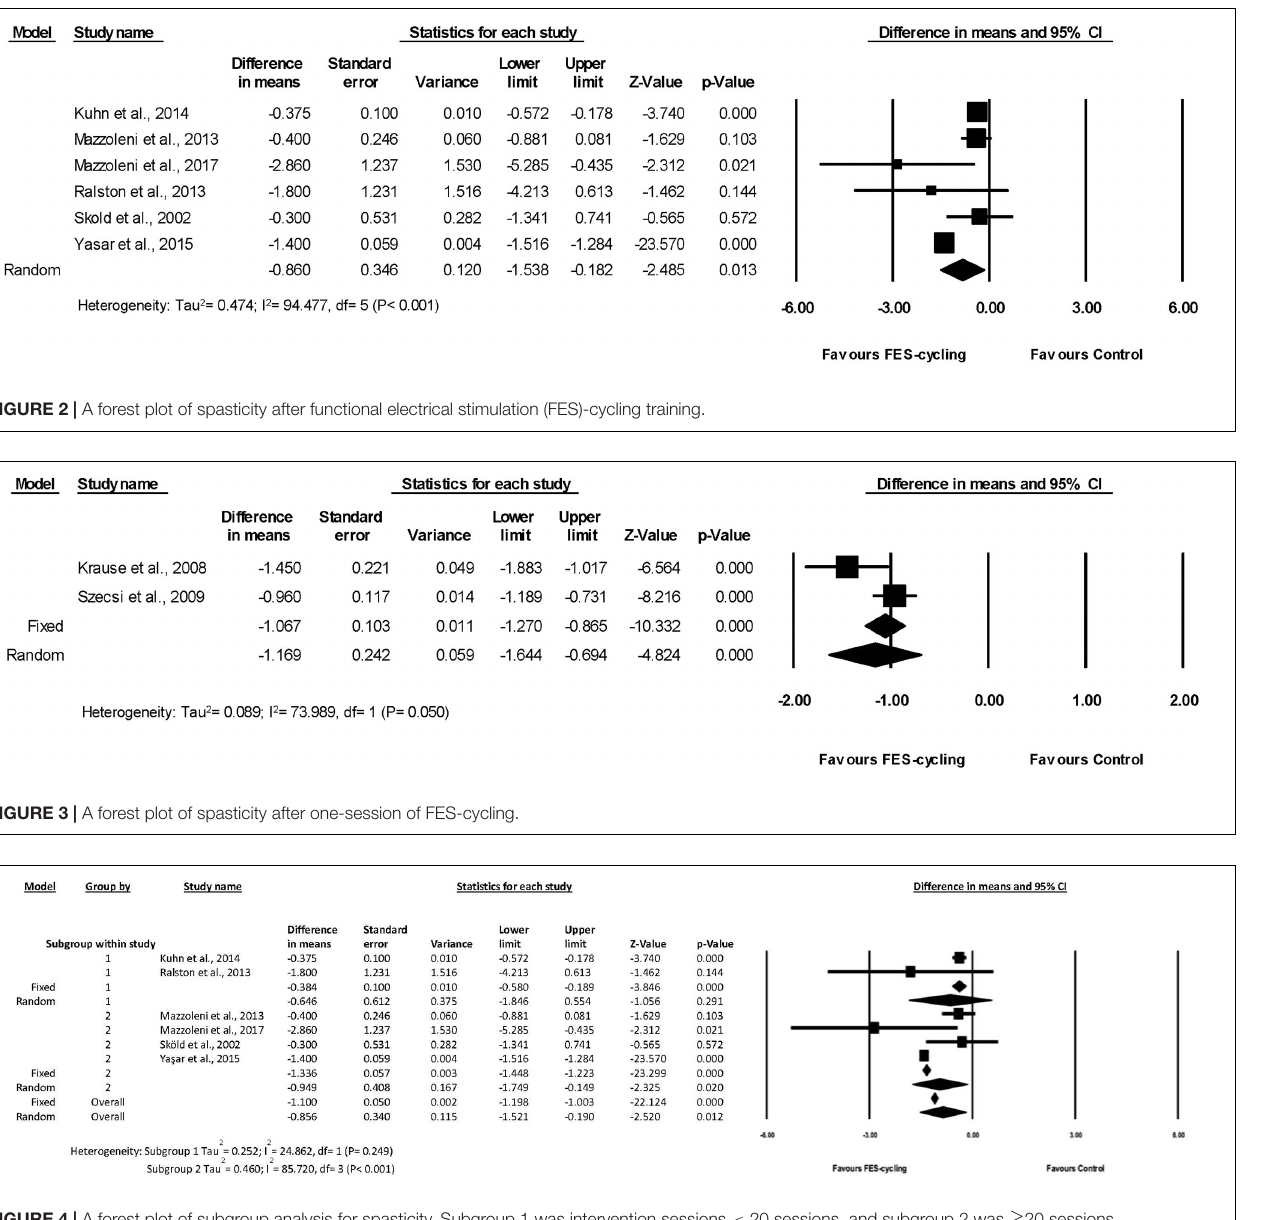
FIGURE 4 | A forest plot of subgroup analysis for spasticity. Subgroup 1 was intervention sessions < 20 sessions, and subgroup 2 was (cid:61) 20